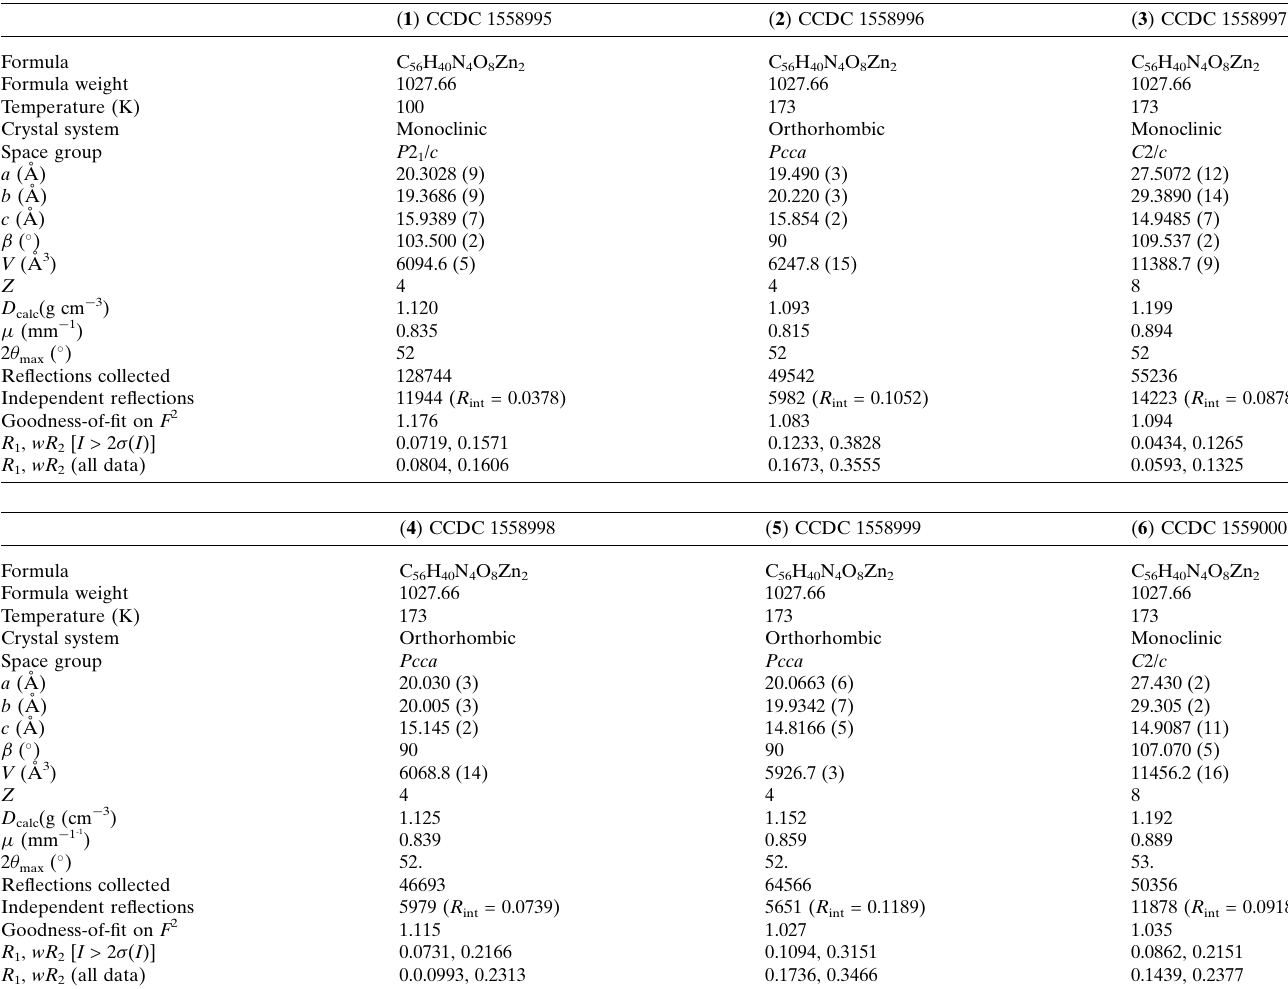
Table 1 Crystallographic data and refinement parameters of ( 1 )-( 6